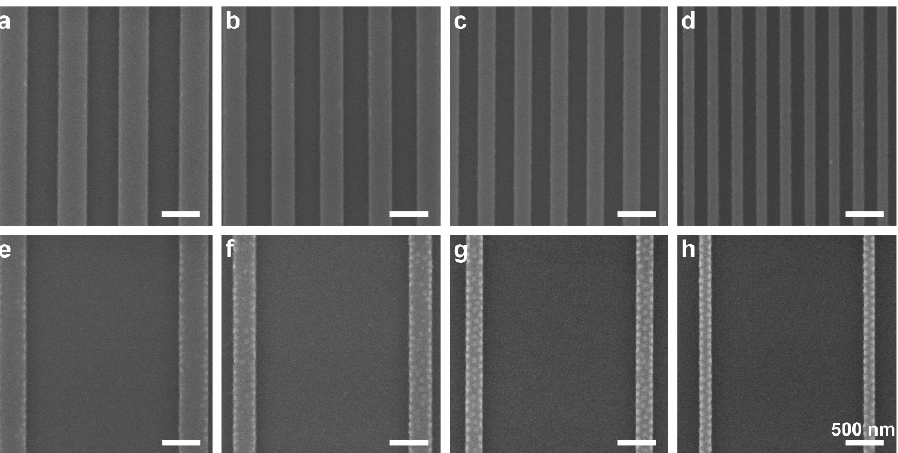
Figure 5. SEM images of films cast on substrates featuring 38 nm-deep trenches and equal plateau and trench widths: ( a ) 400 nm; ( b ) 320 nm; ( c ) 240 nm; ( d ) 160 nm. Nominal film thickness is 23 nm. Bright and dark stripes correspond to the plateaus and trenches, respectively. ( e – h ) SEM images of the same trench depth (38 nm) and respective plateau widths, spaced by 2 µm-wide trenches. All scale bars represent 500 nm.